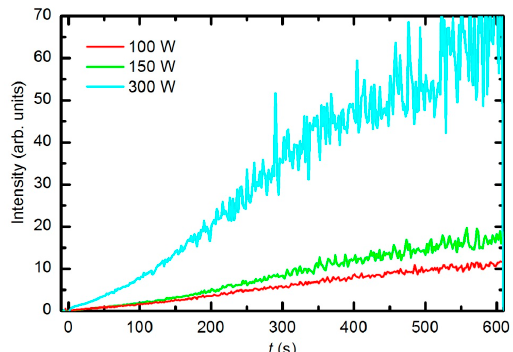
Figure 9. Time evolution of the CO emission peak (519.5 nm) normalized by the O (777.4 nm) line during sample treatment with oxygen plasma; the RF forward power is shown in the key.